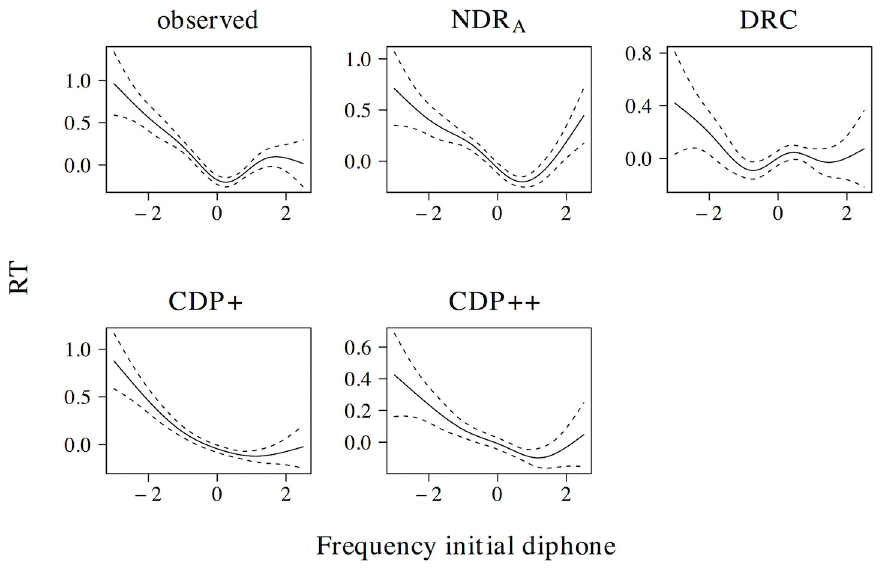
Fig 19. Initial diphone frequency. The effect of the frequency of the initial diphone in word naming.